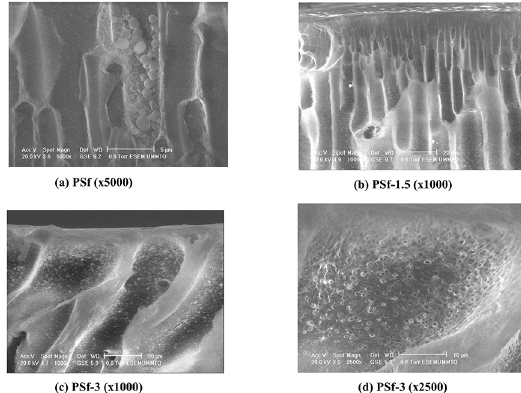
Figure 9: SEM images of the prepared membranes showing the honeycomb-cell morphology: (a) PSf (×5000), (b) PSf-1.5 (×1000), (c) PSf-3 (×1000) and (d) PSf-3